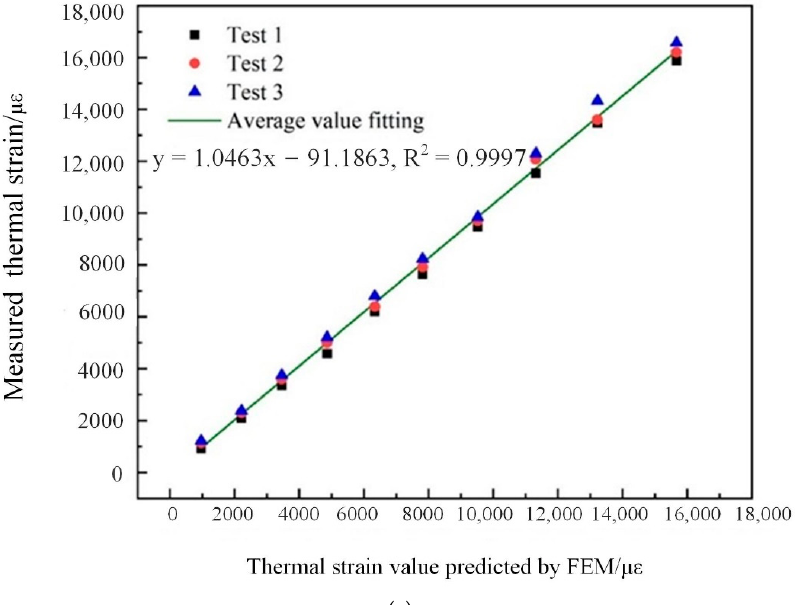
Figure 9. Temperature response of the CFPI sensor. ( a ) The relationship between the OPD of the silica-cavity IFPI and the applied temperature; ( b ) thermal strain measured by the air-cavity EFPI under different temperatures; ( c ) comparison between the measured thermal strain and predicted value by FEM simulation.